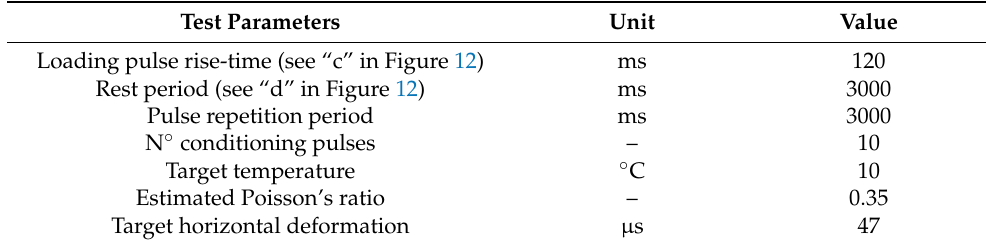
Figure 12. ITSM loading configuration. Table 6. ITSM test loading parameters.